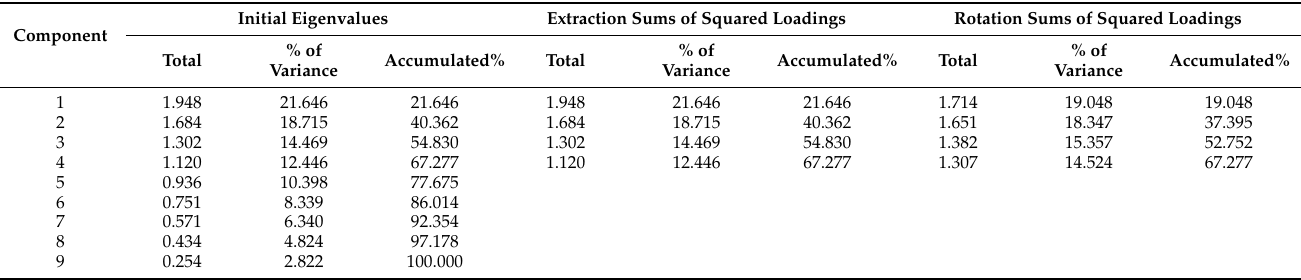
Table 4. Total variance explained. Source: own